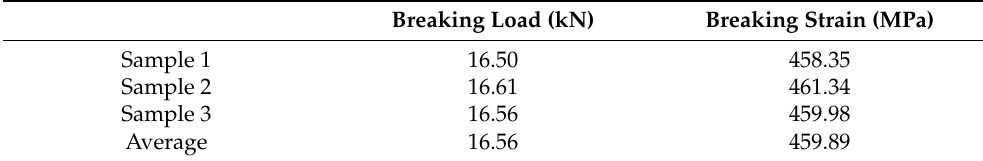
Table 3. Breakings values of steel of the tubes.